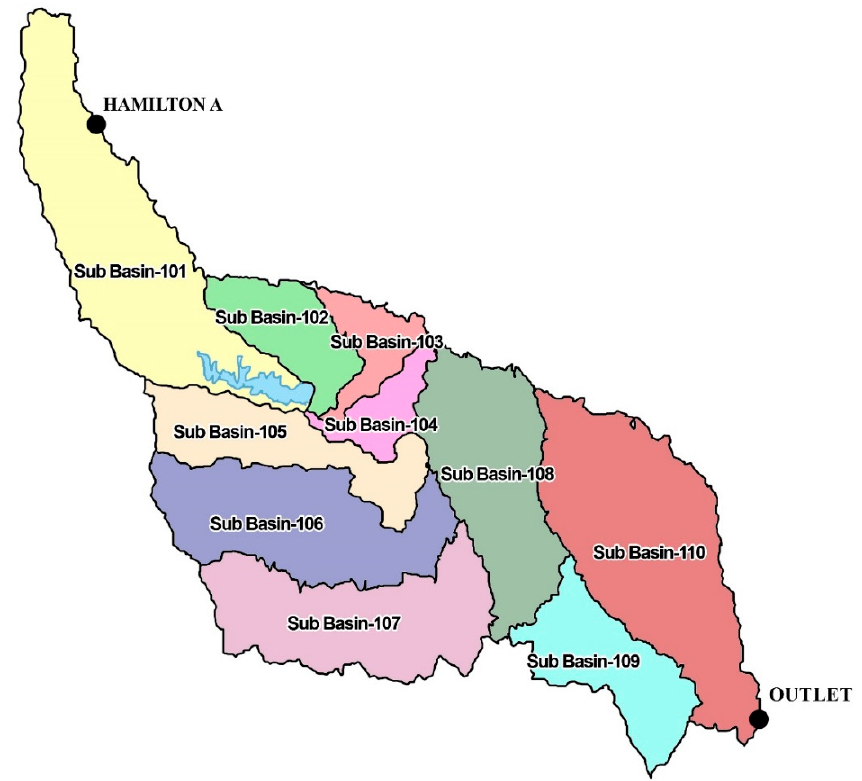
Figure 2. Division of Upper Welland River Watershed (UWRW) into sub-basins with outlet. The other details available in Geographical Information System (GIS) layers include 10 m Digital Elevation Model (DEM) (Figure 3), stream network, land use (Figure 4), and soil type (Figure 5). This information was provided by the Ontario Ministry of Natural Resources (MNR), Ontario Ministry of Agriculture, Food and Rural Affairs (OMAFRA), and NPCA. The dominant Hydrologic Soil Groups (HSGs) are type C and D, and approx- imately 85% of the land is under crop and other agricultural use.